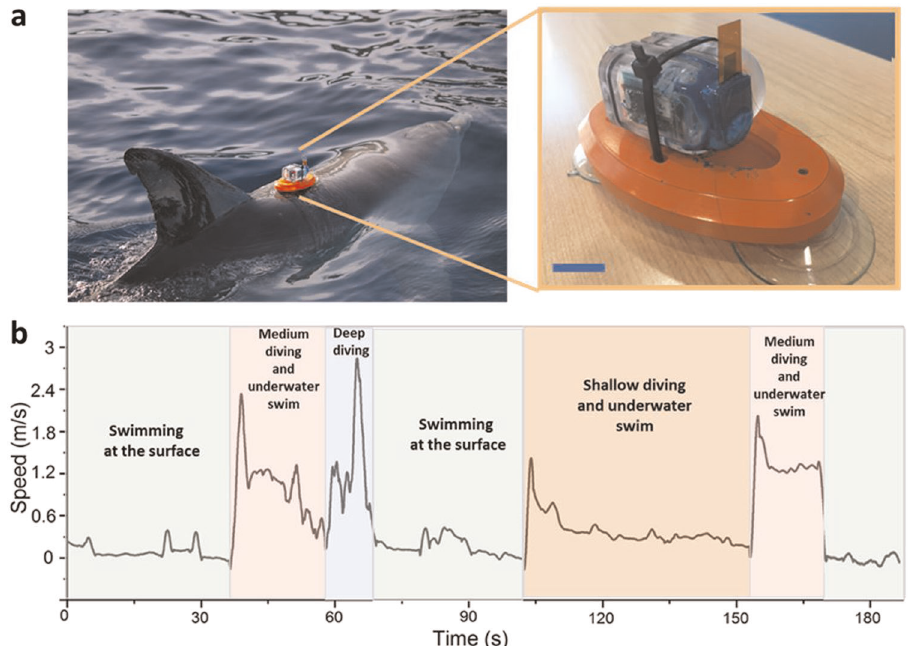
Fig. 10 a LIG bending sensor integrated with ultra-low power Aquamote tag (scale bar: 2 cm) and attached to a dolphin ’ s spine. b The resistance of the LIG sensor and corresponding swim speed of the dolphin as a function of time for a duration of 3 min